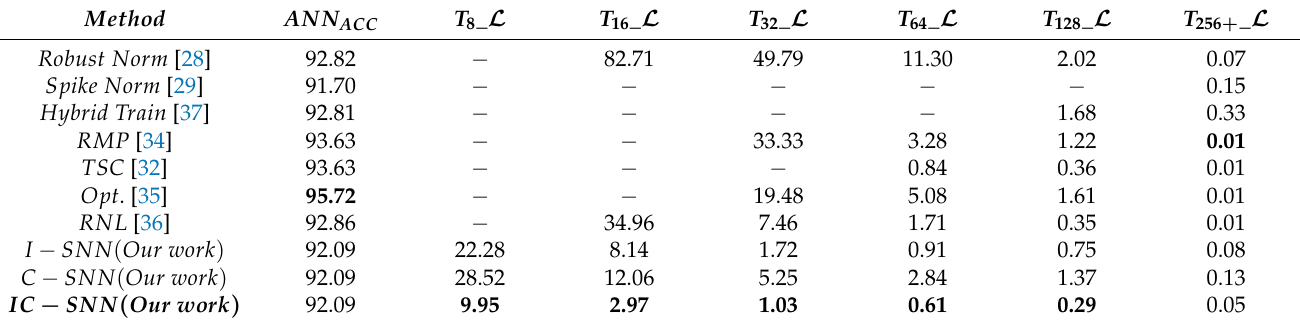
Figure 7. The output of the neural network at different time steps. Among them, ( a , c , e ) are the outputs of the first-layer network using 8, 16, and 32 time steps, respectively; ( b , d , f ) are the outputs of the third-layer network using 8, 16, and 32 time steps, respectively. Table 2. Results of the test on the CIFAR10 dataset using